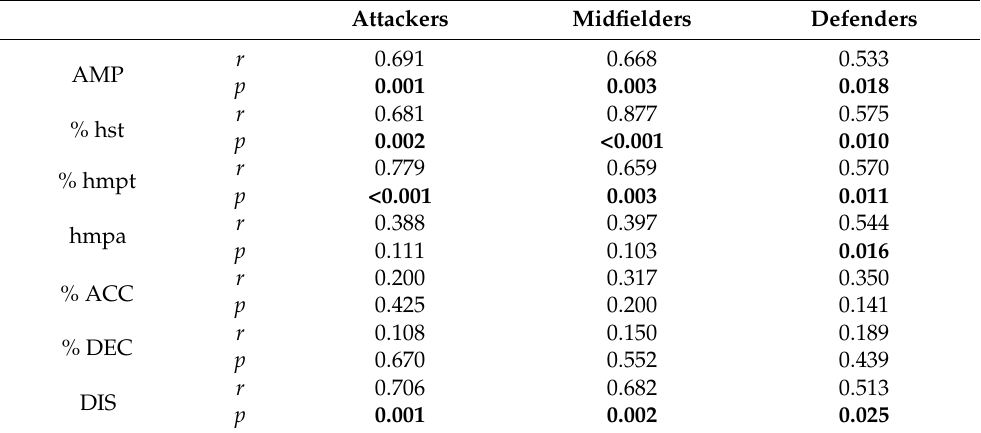
Table 5. Pearson’s correlation between the measured variables and the different A P of the SSGs. Attackers Midfielders Defenders r 0.691 0.668 AMP